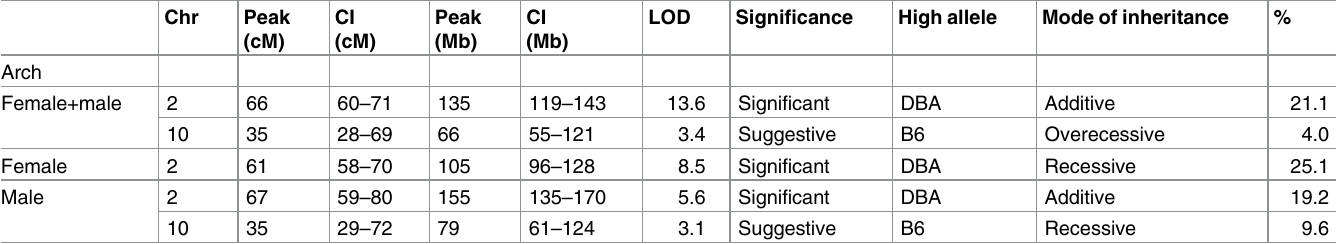
Table 2. QTLs for atherosclerosis at the aortic arch in F2 mice from intercross between DBA-apoE and B6-apoE.